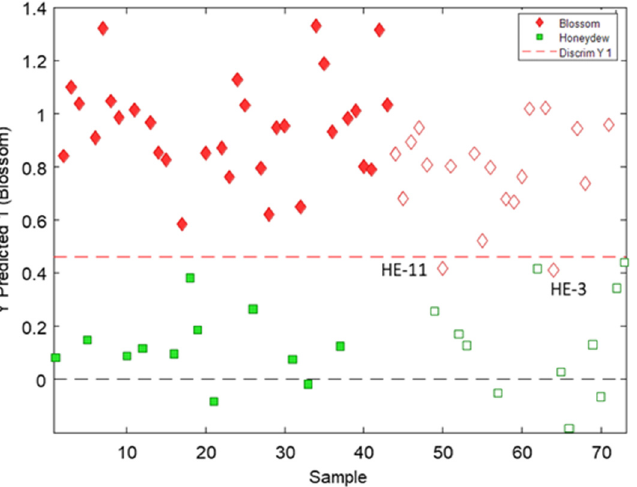
Figure 5. Two-class classification models obtained by PLS-DA of blossom versus honeydew honeys. The calibration set (filled symbols) comprises the 60% of all samples randomly chosen and the prediction set (empty symbols) comprises the 40% remaining samples.